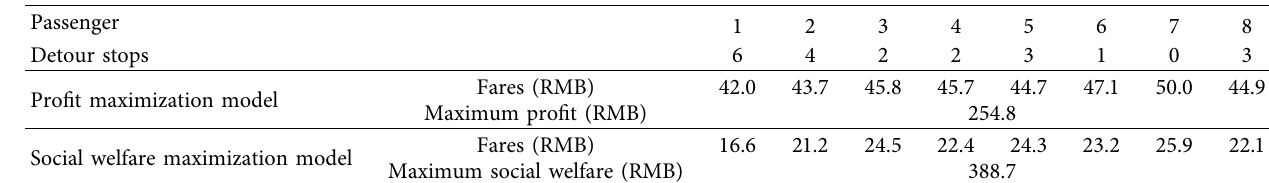
Table 4: Results of case 2.